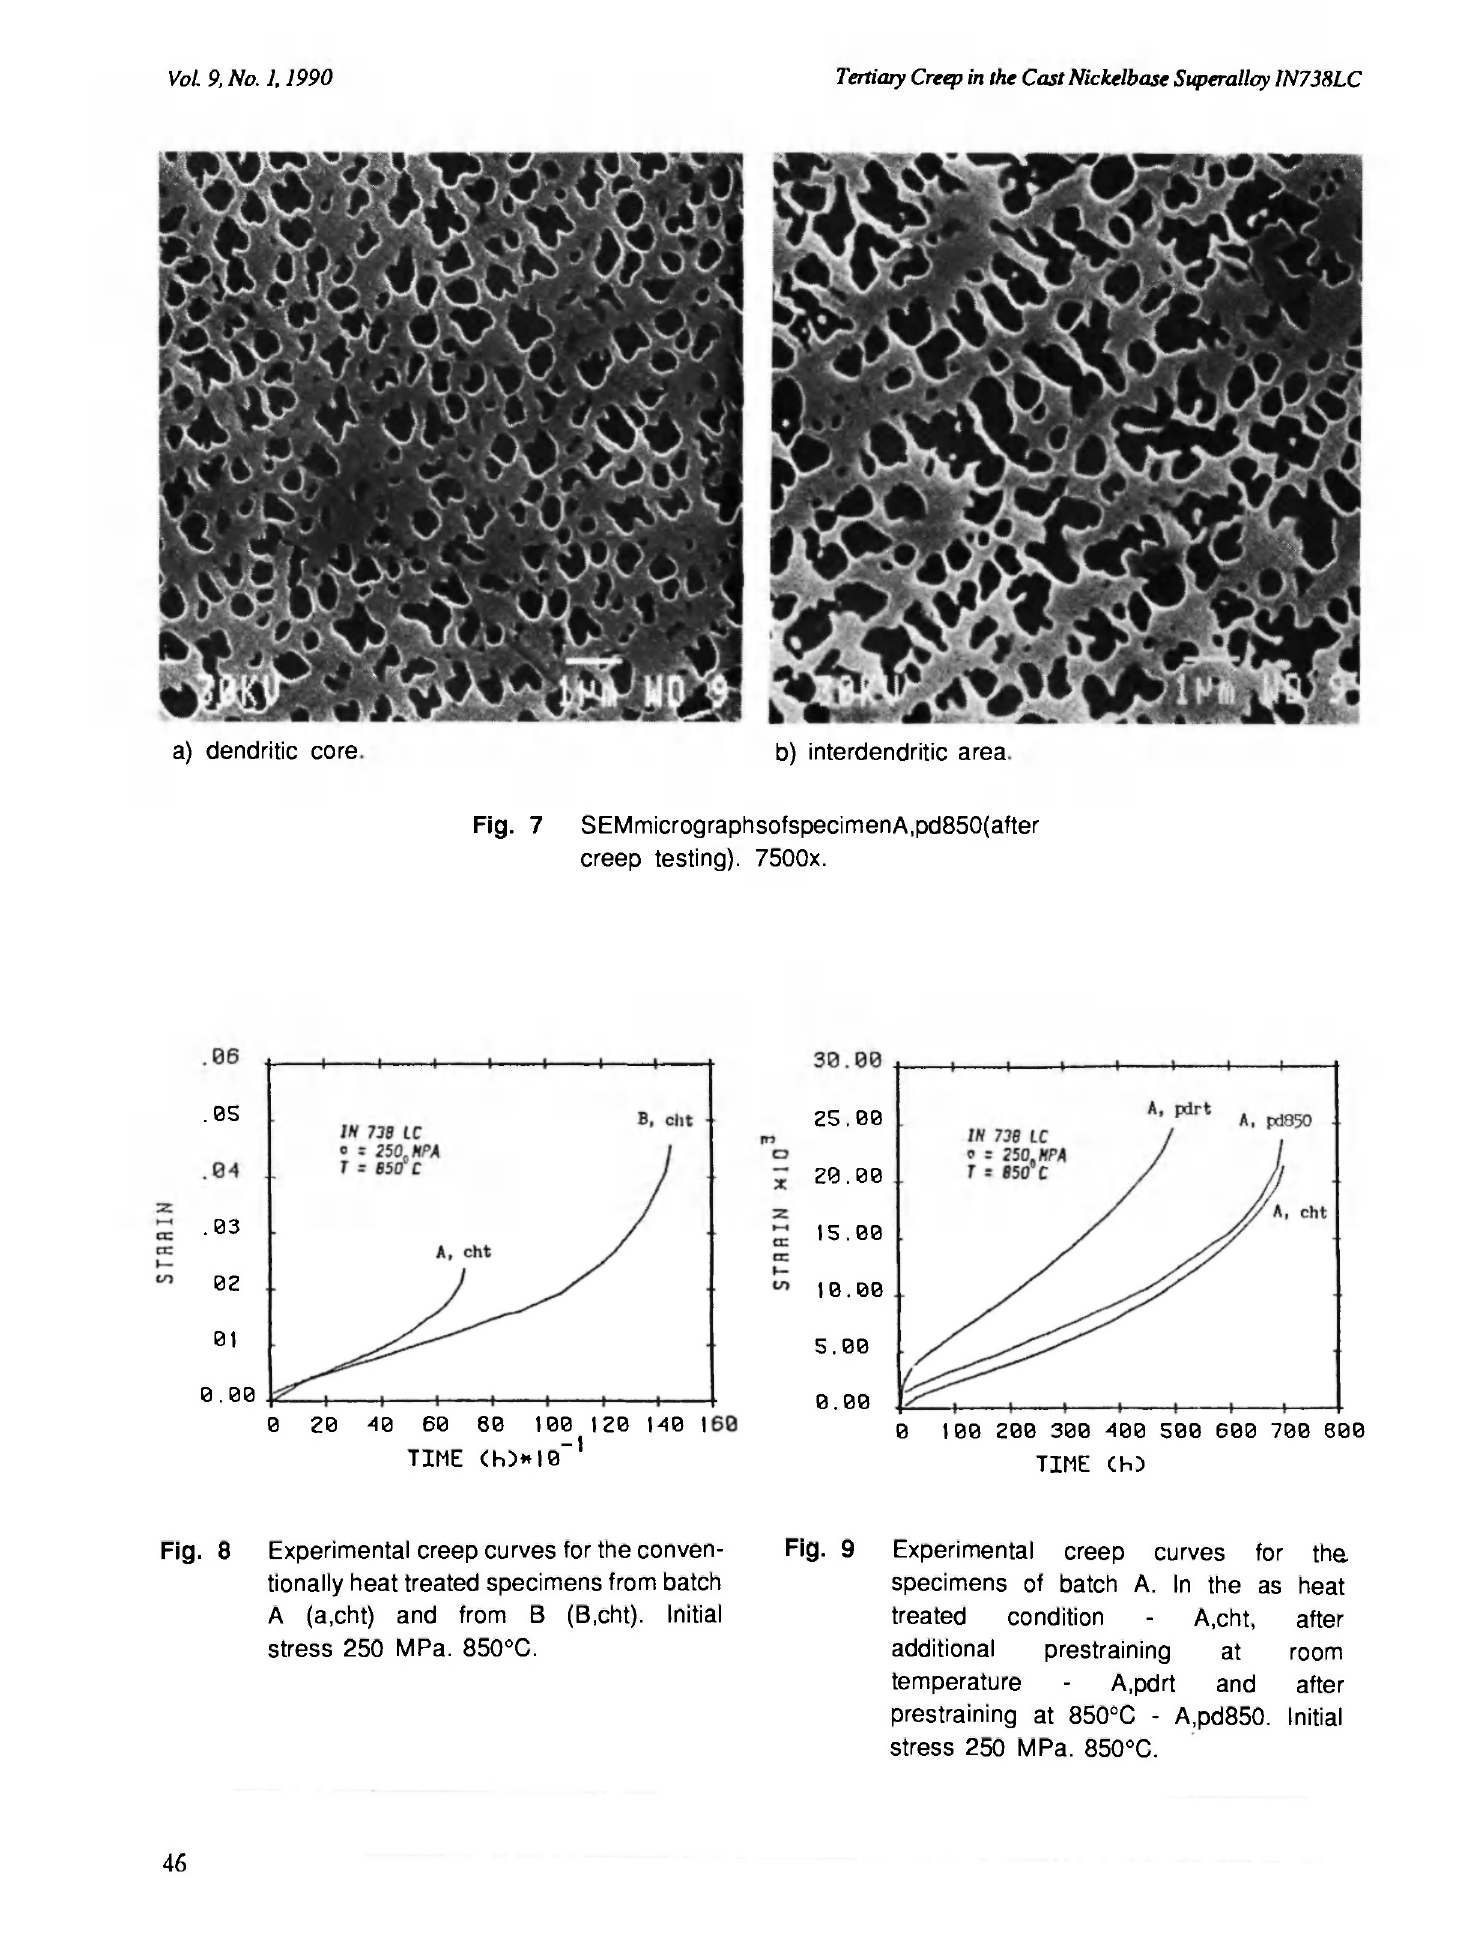
Fig. 9 Experimental creep curves for the specimens of batch A. In the as heat treated condition - A,cht, after additional prestraining at room temperature - A.pdrt and after prestraining at 850°C - A,pd850. Initial stress 250 MPa.